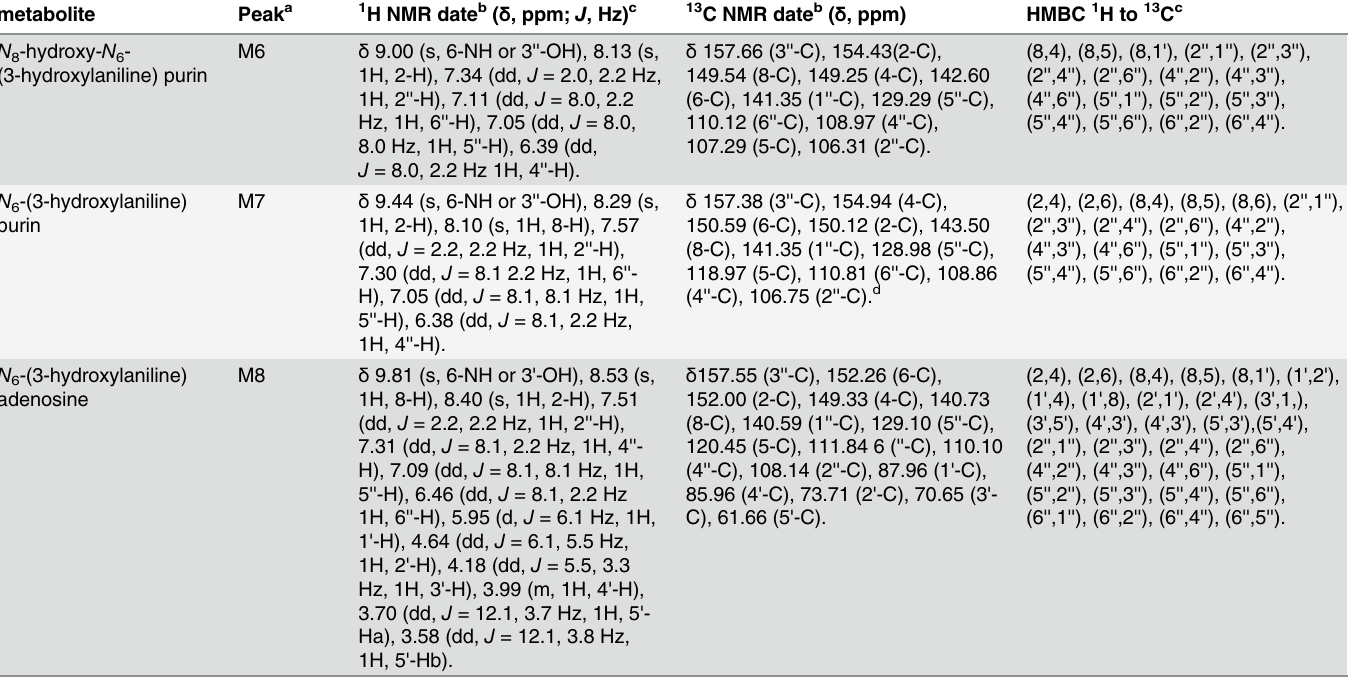
gave a fragment ion peak at m/z 360, confirming the above result. A comparison of the 1 H and 13 C NMR spectra of M4 to those of M8 revealed their close resemblance (Fig 3: M4, M8 and Fig 4: M4, M8). The main difference between M4 and M8 was the appearance of a glucuronyl group in M4, with its signals being observed at δ 4.83 (d, J = 7.2 Hz, 1H, 1'''-H), 3.42 (m, 1H, 5'''-H), 3.26 (m, 1H, 3'''-H), 3.23 (m, 1H, 2'''-H) and 3.18 (m, 1H, 4'''-H) in the 1 H NMR spec- trum; and at δ 100.69 (1'''-C), 76.89 (3'''-C), 74.68 (5'''-C), 73.44 (2'''-C) and 72.41 (4'''-C) in the 13 C NMR spectrum, respectively. The coupling constant of the anomeric proton was in the range of 7 – 8 Hz which allowed its β -configurationto be assigned [32]. The glucuronyl group was confirmed by extensive explorations on the 1D and 2D NMR experiments. The 1 H- 1 H COSY experiment established the spin system from 1'''-H to 5'''-H in glucuronyl group, and the HMBC experiment (S4 File) showed the long range 1 H- 13 C correlations from H-8 to C-4, 5 and 1'; H-2 to C-4 and 6; NH-6 to C-6, 1'', 2'' and 6''. The long range 1 H- 13 C correlation in HMBC from H-1''' to C-3'' strongly indicated that the linkage of glucuronyl group and aniline -(3- O - β -D- between C-3'' and C-1''' was through ether bond. Thus M4 was determined as N 6 glucuronyphenyl) adenosine. H N O S As determined by HRMS at m/z 440.0896, the molecular formula for M5 was C 16 17 5 8 (Table 1: M5). ESI-MS 2 of the pseudomolecular ion peak at m/z 440 [M+H] + yielded the char- ] + and 308 [M+H-ribofuranose-3-OH] + . A com- acteristic ion peaks at m/z 360 [M+H-HSO 3 parison of the 1 H and 13 C NMR spectra of M5 to those of M8 (Table 2, Fig 3: M5, M8 and Fig 4: M5, M8) revealed their close resemblance. The main difference was the downfield